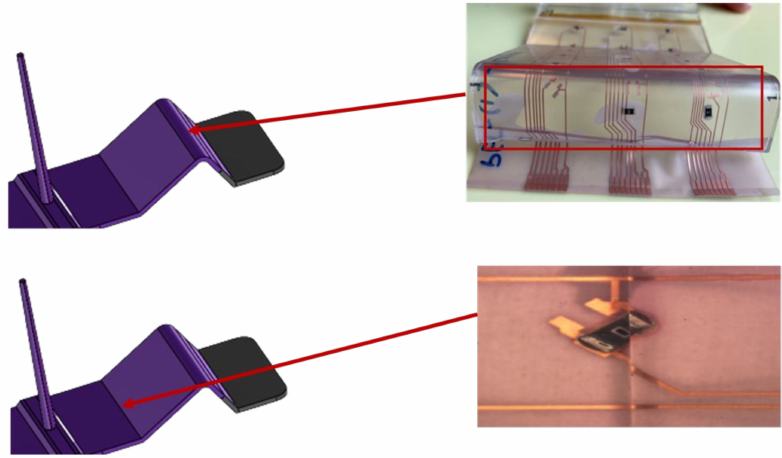
Figure 43. Corner mold critical areas.